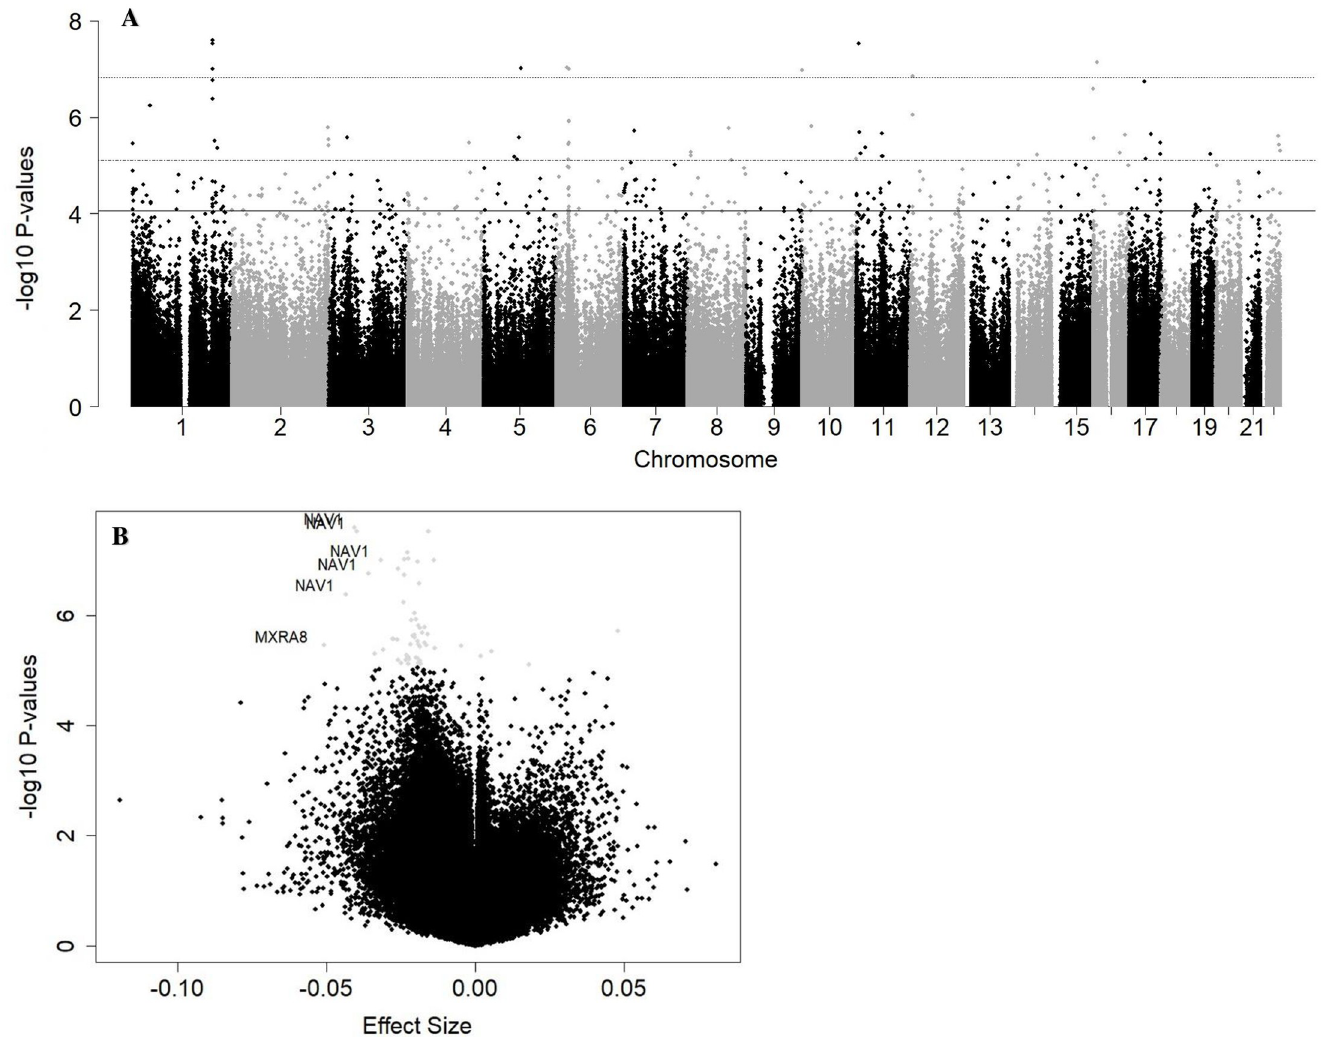
Fig 1. Results of placental DNA methylation and night shift work EWAS. A, Manhattan plot of CpG results, adjusted for maternal age, pre-pregnancy smoking, adversity score, sex of the infant, and estimated cell mixture. The dashed upper boundary line denotes p-value of 1.49x10-7 as the significance threshold after Bonferroni adjustment (p < 0.05), the dashed middle boundary line denotes the p-value of 7.7x10-6 as the approximate significance threshold of BH q < 0.05, and the solid boundary line at denotes the p-value of 8.8x10-5 as the approximate significance threshold of BH q < 0.10. B, Volcano plot of results, adjusted for maternal age, pre-pregnancy smoking, adversity score, sex of the infant, and estimated cell mixture. Gray dots signify CpG sites with BH q < 0.05 and CpG sites with both absolute beta coefficients of 0.03 or greater and BH q < 0.05 are labelled with UCSC gene names.